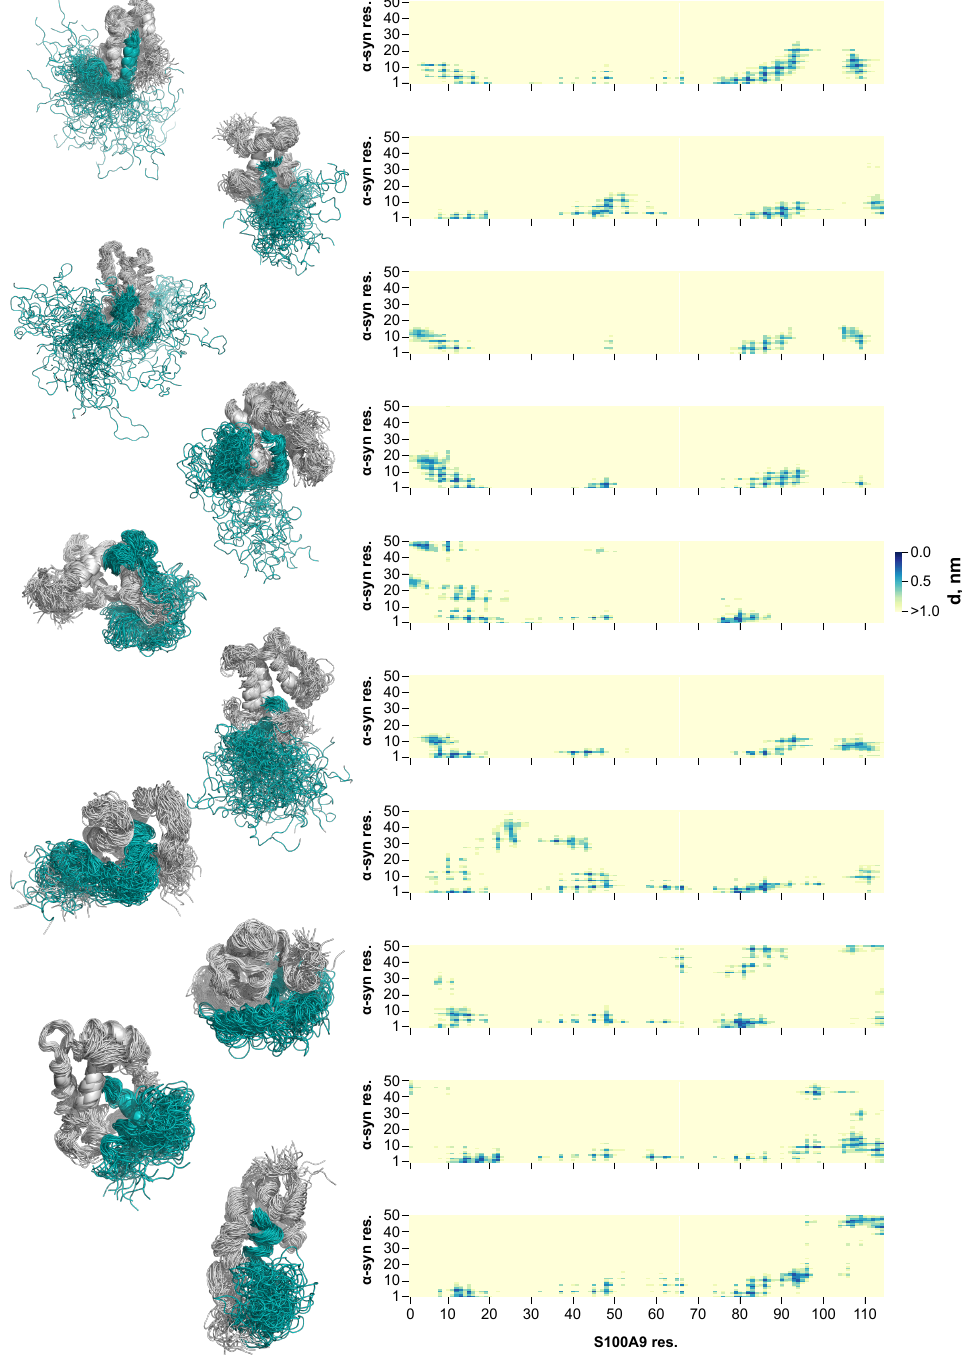
Figure A3. Structures of clusters, which showed the highest fractional cluster occupancy and their inter-residue contact maps. Gray cartoon—S100A9; teal— α